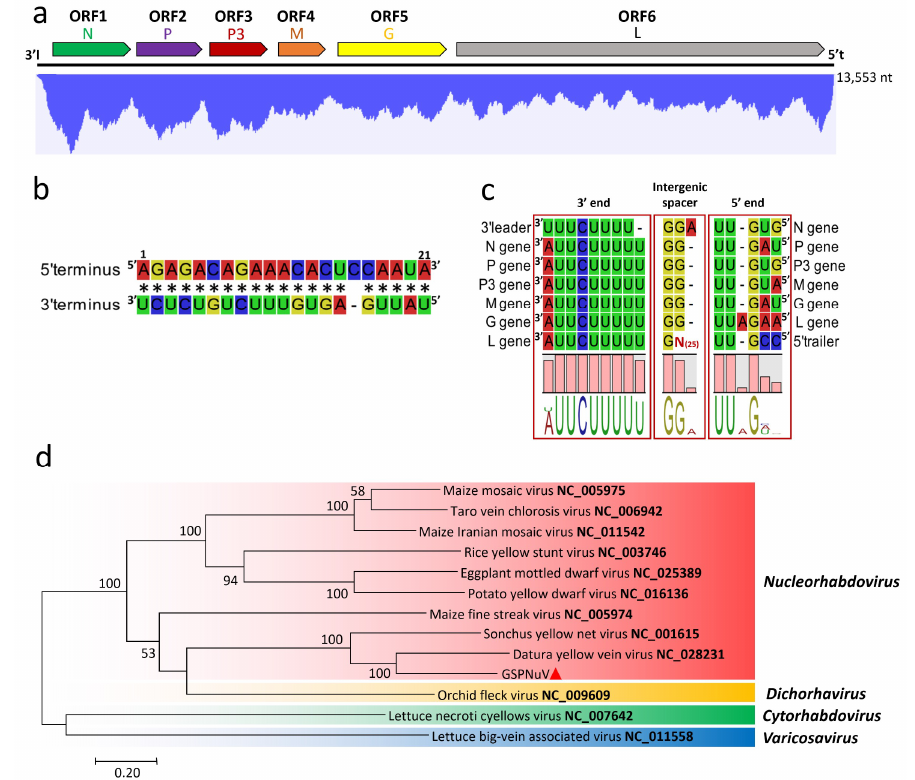
Figure 5. ( a ) Genomic structure of green Sichuan pepper-nucleorhabdovirus (GSPNuV) and profile distribution of transcriptomic reads from GSPNuV. N, P, P3, M, G, and L are putative nucleocapsid protein, phosphoprotein, movement protein, matrix protein, glycoprotein, and polymerase, respectively. 3'l and 5't are a leader sequence at 3' genomic terminus and a trailer sequence at the 5' terminus, respectively; ( b ) the complementary sequences of the 5' and 3' termini (asterisk indicates complementary bases); ( c ) conserved gene junction sequences interposed between two adjacent genes; ( d ) phylogenetic tree generated using the maximum-likelihood method (JTT model) and 1000 bootstrap replicates, based on alignment of amino acid sequences of the L genes from GSPNuV (marked with small red triangle) and related viruses. Bootstrap percent values greater than 50 are shown at the nodes. The viral accession number is marked in bold in taxa